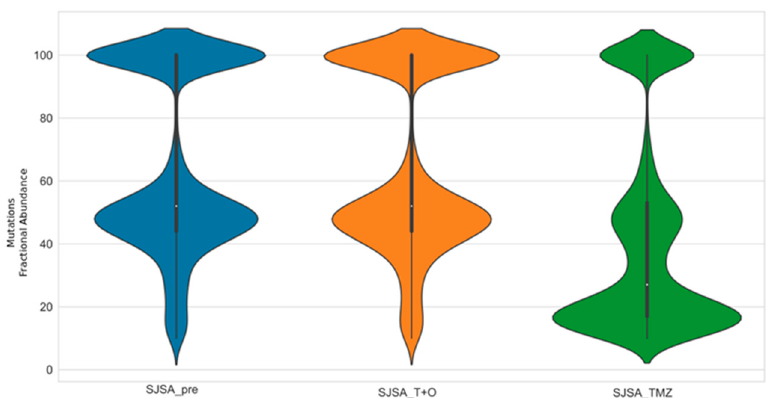
Figure 7. Clonality at baseline, after trabectedin + olaparib combination and after temozolomide treatment in the SJSA-1 cell line. The distribution of mutations fractional abundance for each treatment setting was showed SJSA_pre = SJSA-1 before treatment; SJSA_T + O = SJSA-1 after trabectedin + olaparib combination; SJSA_TMZ = SJSA-1 after temozolomide treatment.